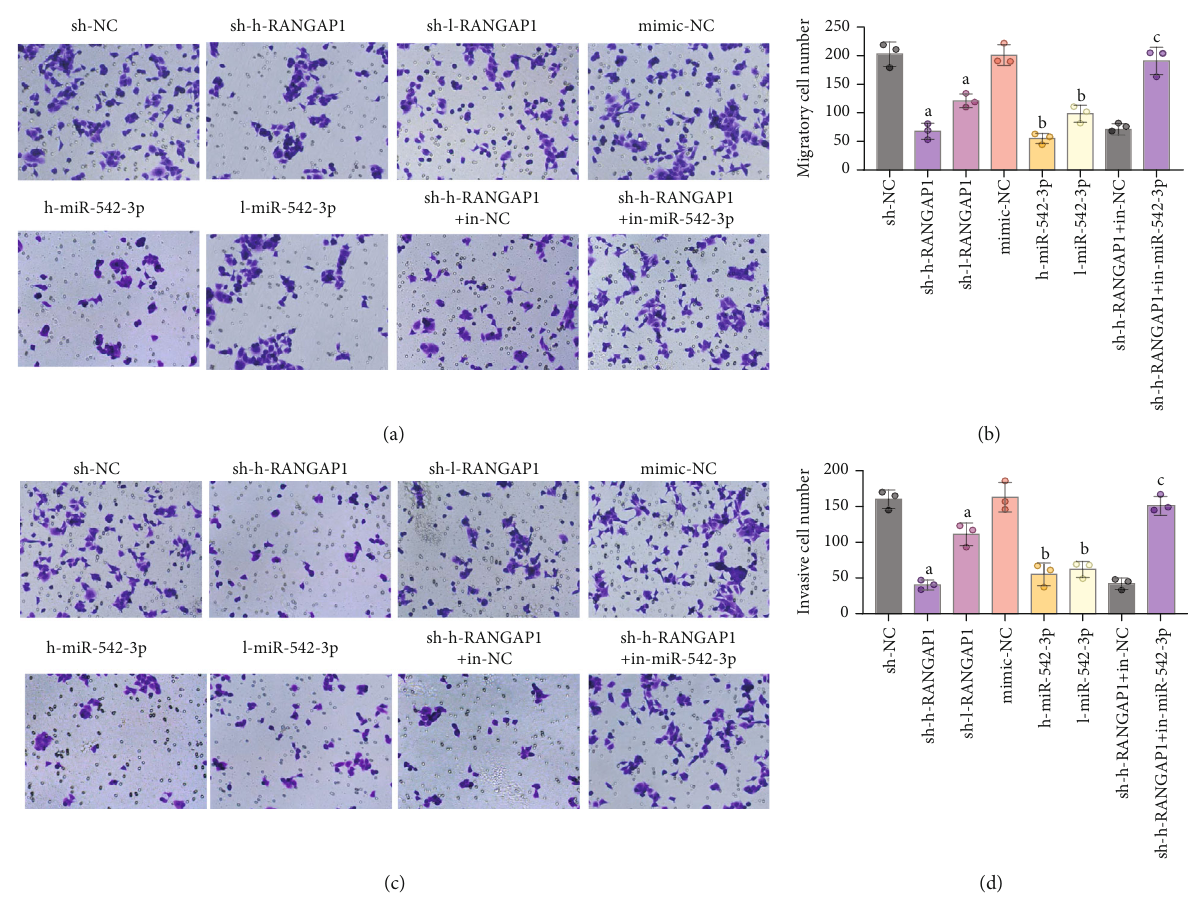
Figure 4: The cell migration and invasion in each group. (a) Statistical graph of migration ability of MG63 cells in each group. (b) Detection of MG63 cell migration in each group was via Transwell assay. (c) Statistical graph of MG63 cell invasion in each group. (d) Test of MG63 cell invasion in each group was via Transwell assay. The data in the fi gure were all measurement data in the form of mean ± SD . A represented P < 0 : 05 versus the sh-NC; b represented P < 0 : 05 versus the mimic-NC; c represented P < 0 : 05 versus the sh-h-RANGAP1